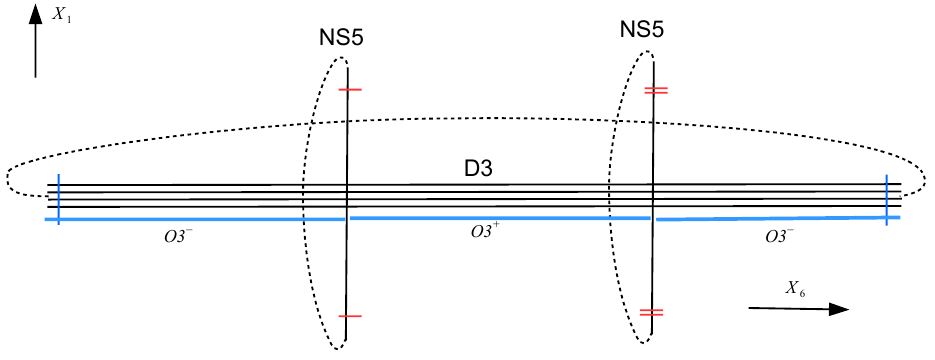
= 4 theory capturing the Coulomb branch of our original N